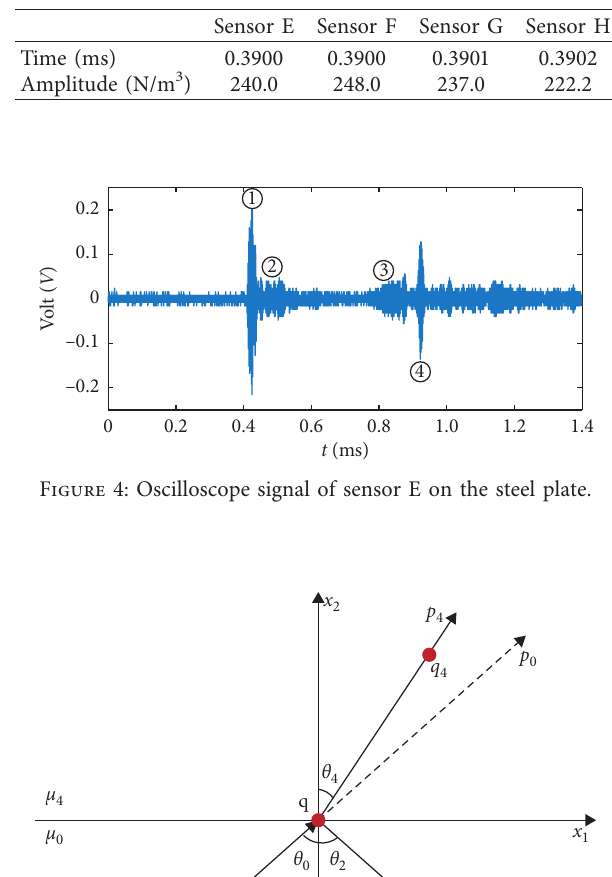
Table 1: The data of signal 3 in the steel plate.